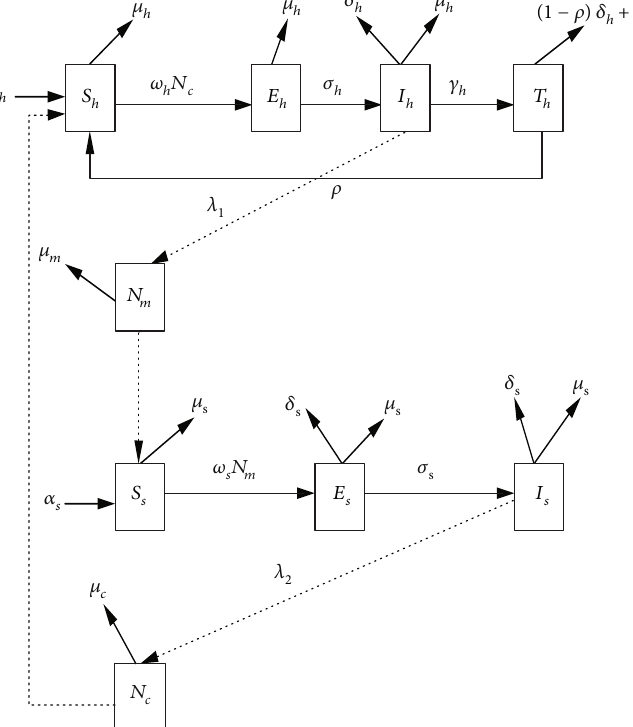
Figure 1: A compartmental chart for the mathematical model.